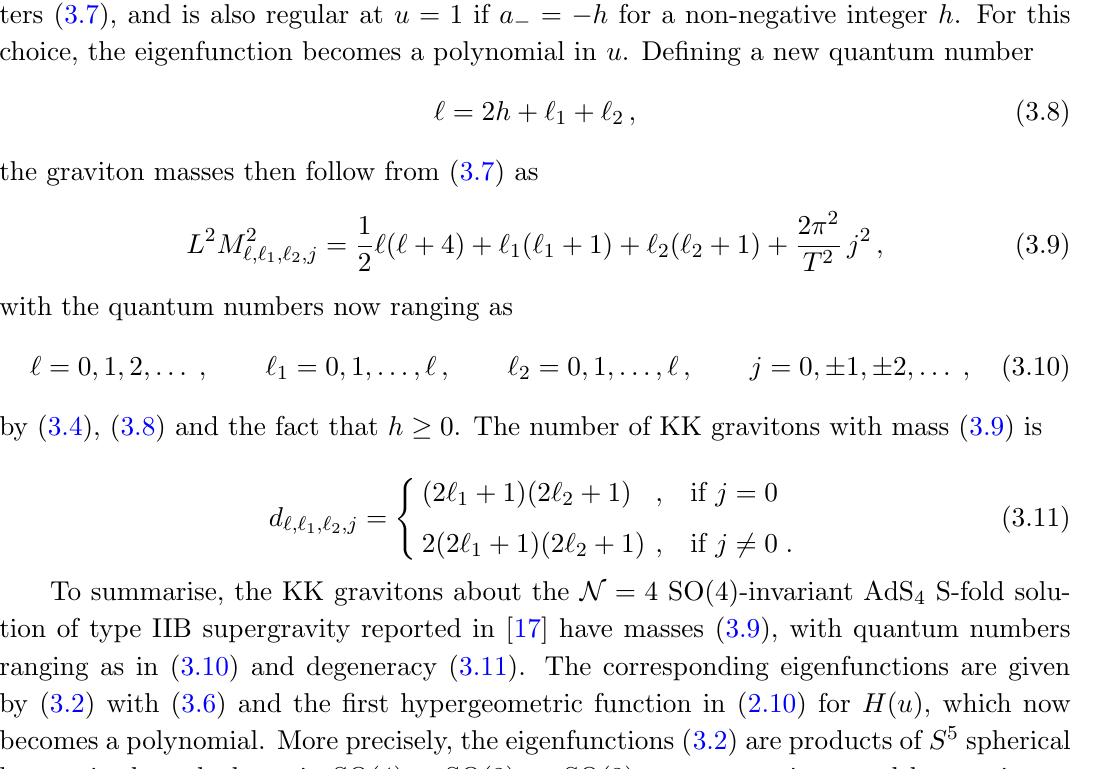
table 5. The table includes the dimension (cid:1) of the corresponding operators in the dual (cid:12)eld theory [50],